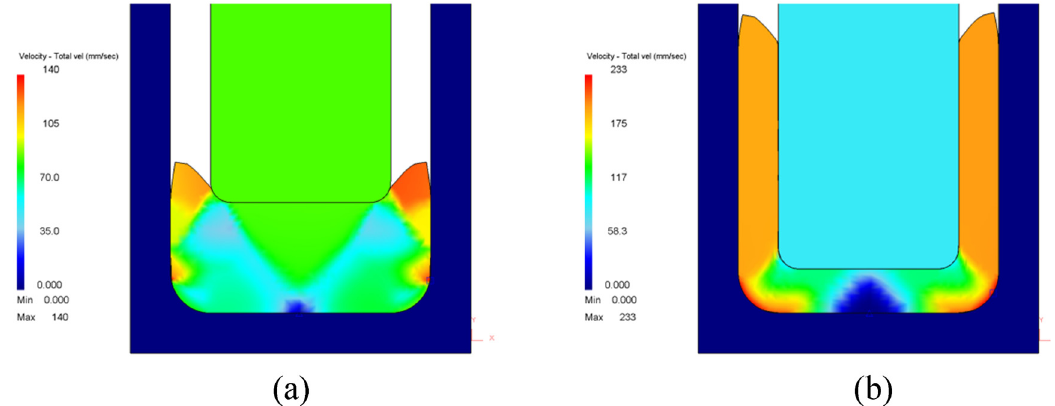
Figure 9: Nephograms of velocity fi eld at di ff erent extrusion moments: ( a ) start point, ( b ) end